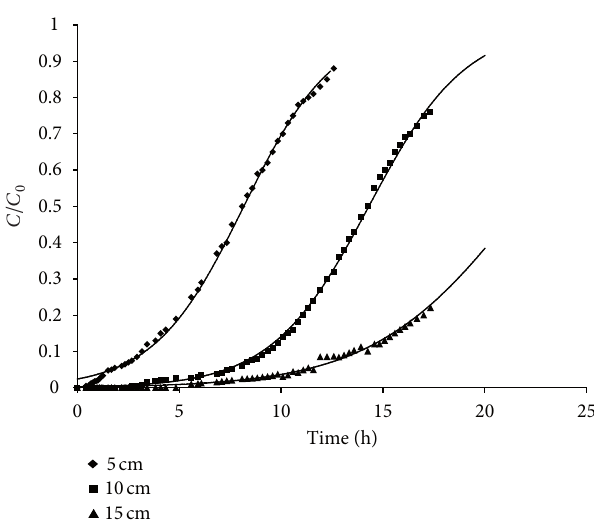
F 4: e omas model curve for MB adsorption onto GNSP at different bed heights. Flow rate = 1l/h, initial dye concentration , pH = = 0.2kg/m 3